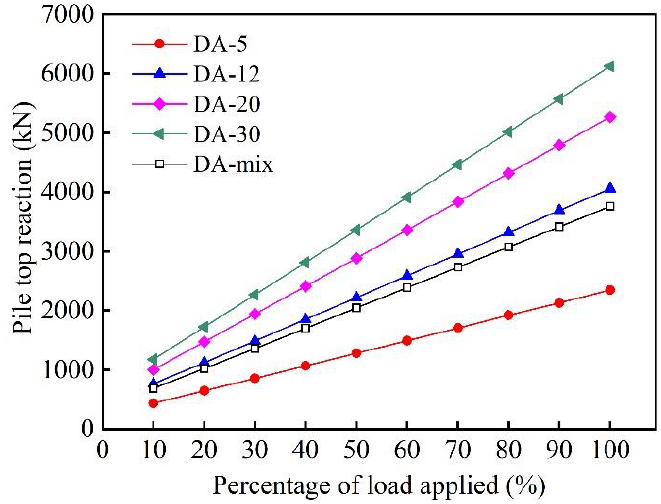
Figure 13. Curve of pile top reaction variation with percentage of load applied .